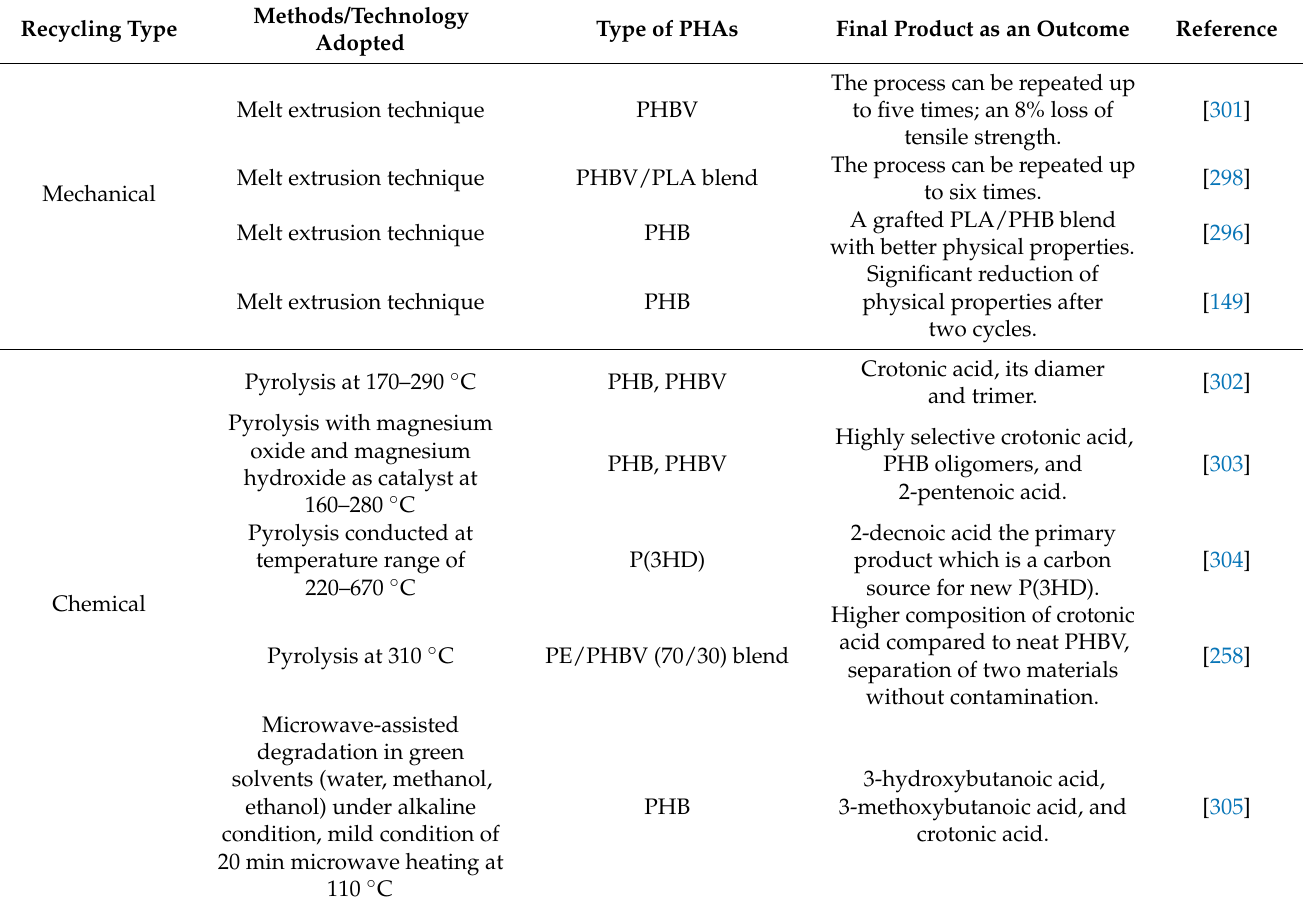
Table 7. Recycling Methods for various PHAs and its